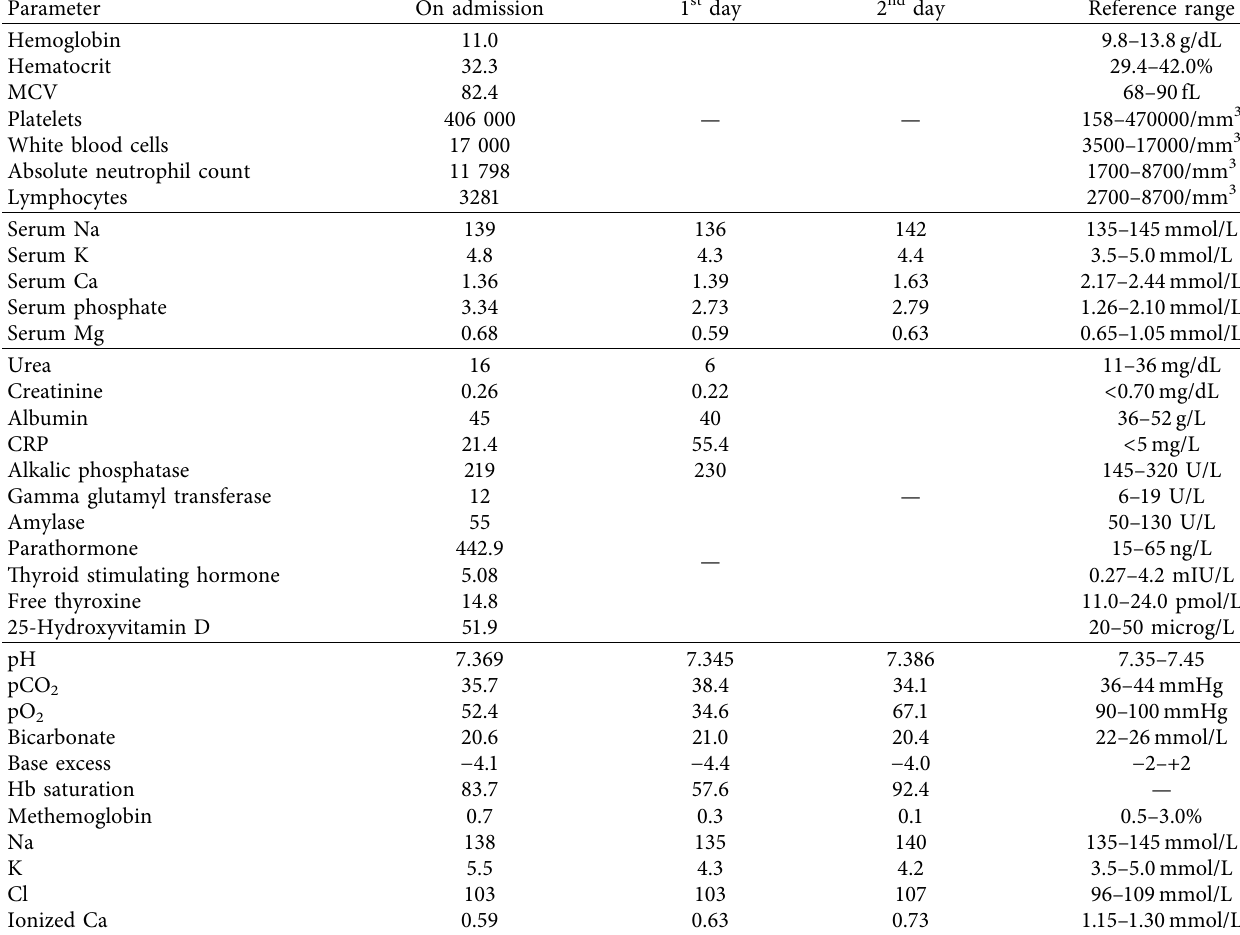
Table 2: Laboratory parameters of our patient.